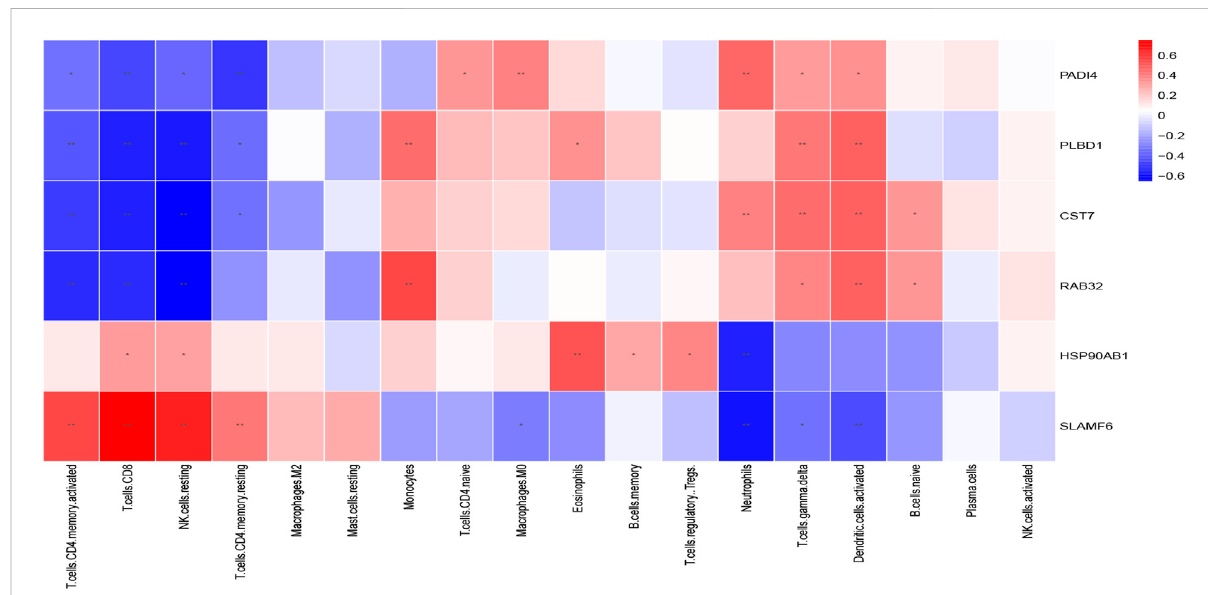
FIGURE 12 The correlation between the immune cells and diagnostic biomarkers; * p < 0.05; ** p <